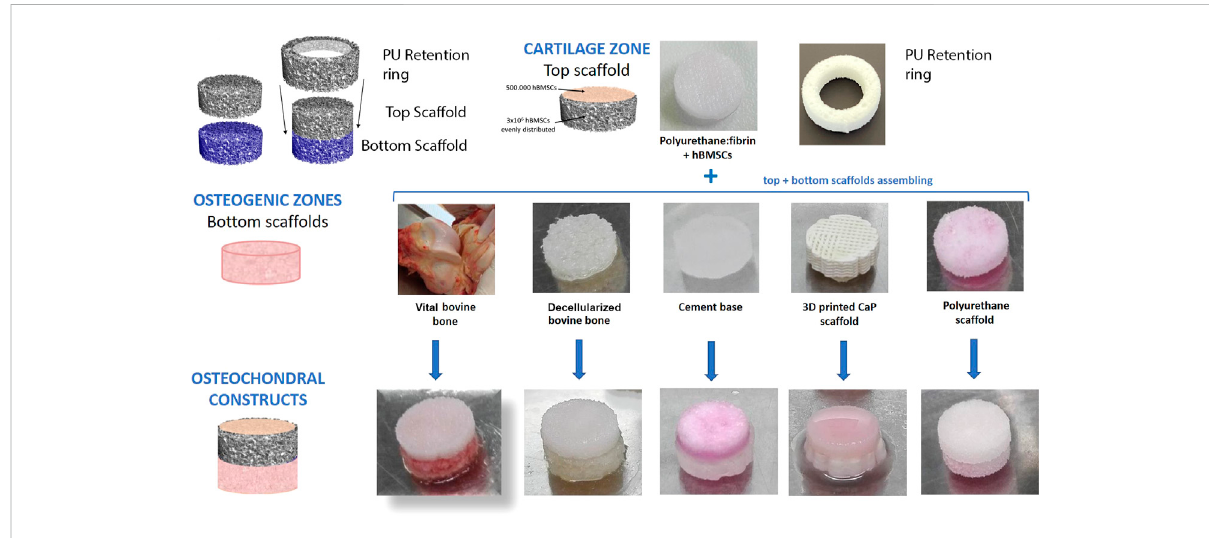
FIGURE 1 Overview of experimental